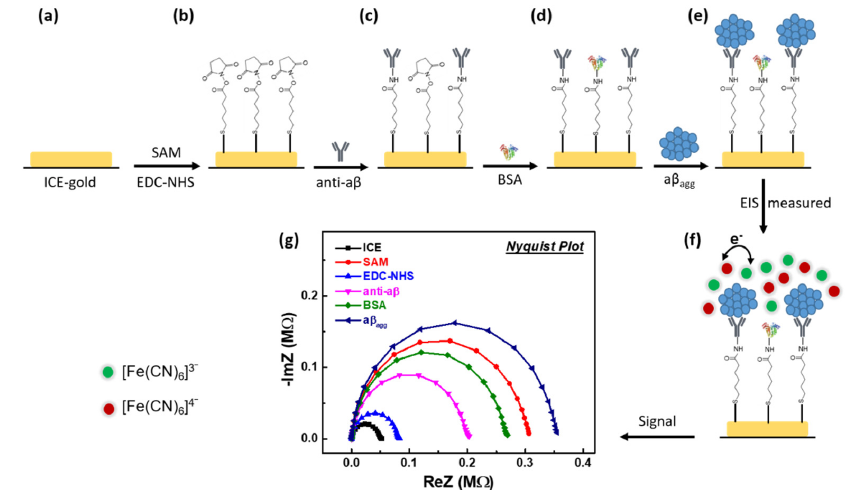
Figure 2. ( a , b , c , d, e ) Development procedure the immunosensor anti-a β /SAM/ICE for the recog- Figure 2. ( a – e ) Development procedure the immunosensor anti-a β /SAM/ICE for the recognition a β agg , ( f ) impedimetric measurement mechanism in the recognition a β agg by the developed biosensor anti-a β /SAM/ICE, and ( g ) impedimetric results represent by Nyquist plot at each step of the development anti-a β /SAM/ICE biosensor in the recognition a β agg .